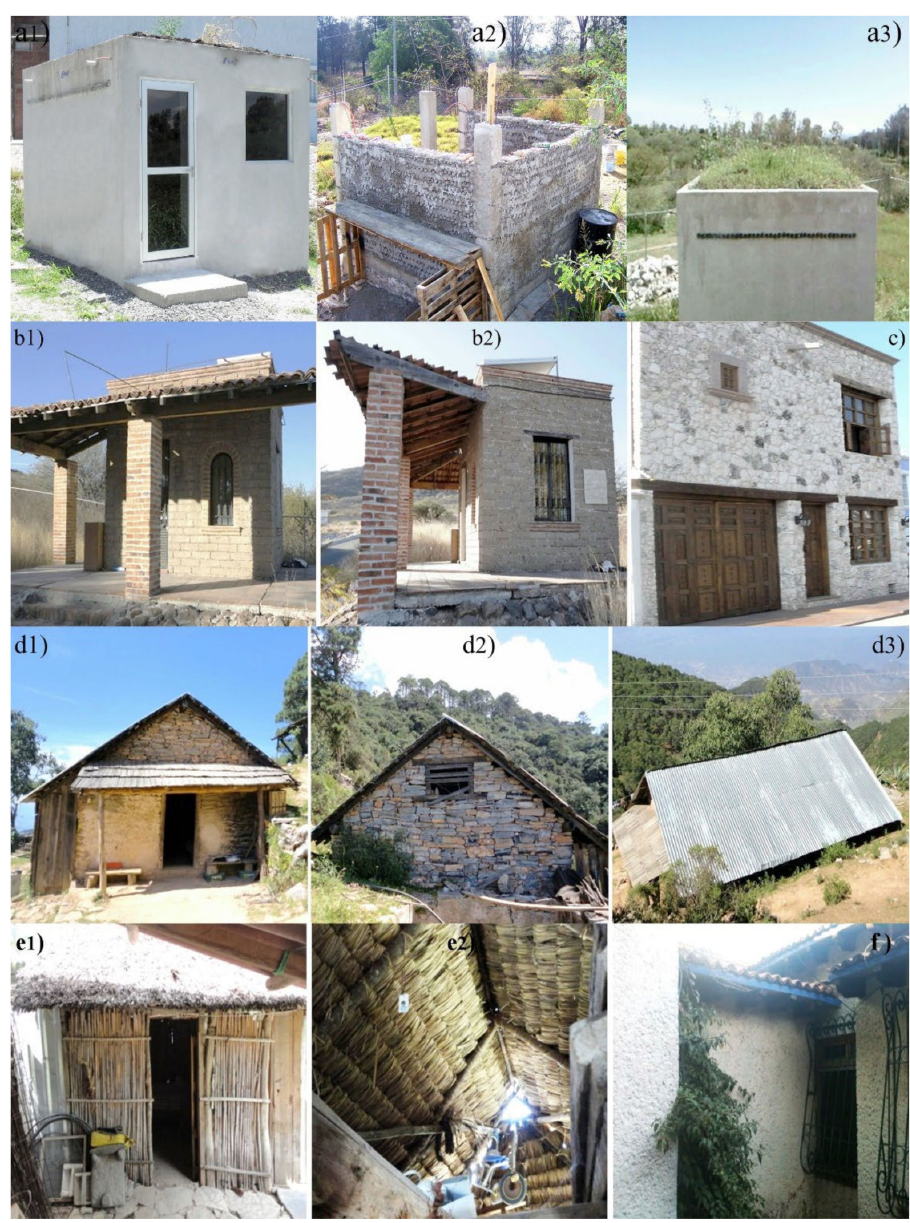
Figure 1. Images of the studied constructions. ( a ) Waste PET bottles prototype in three different views ( a1 ) façade view and right side, ( a2 ) rearview and left side during the construction stage, and ( a3 ) green roof view. ( b ) Photographs of the adobe prototype, ( b1 ) front and ( b2 ) side views. ( c ) Façade of the house built with porous stones from the Peña de Bernal region. ( d ) Flagstone country house located on the slopes of a hill, ( d1 ) front view, ( d2 ) rearview, ( d3 ) rooftop view. ( e ) Bamboo and date palm leaves-thatched roof construction, ( e1 ) front view, ( e2 ) internal view of the roof. ( f ) Red bricks and cement urban house used as a